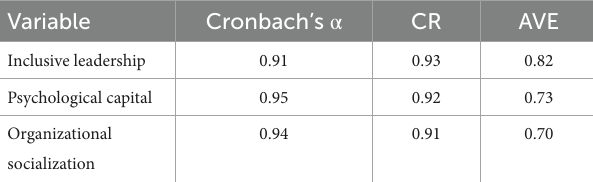
TABLE 2 Reliability and convergent validity